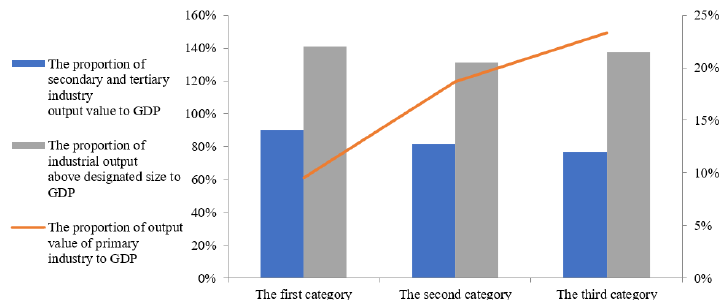
Fig. 5 A comparison of the industrial structures of counties across the three